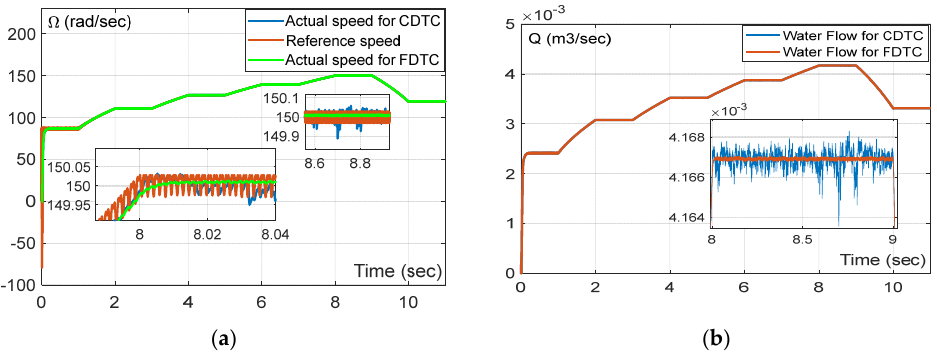
Figure 12. ( a ) Rotor speed evolution for CDTC and FDTC, and ( b ) water flow for CDTC and FDTC.